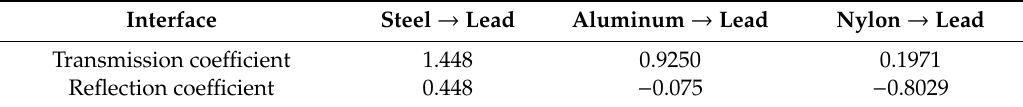
Table 6. Transmission and reflection coe ffi cients between input bar and lead specimen.